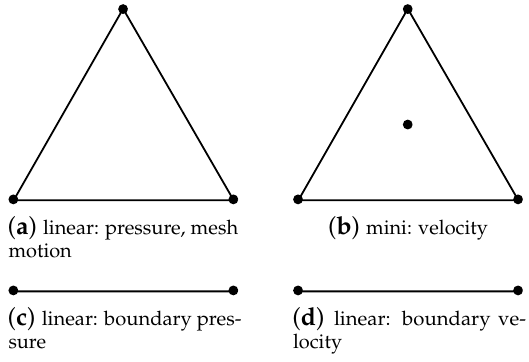
Figure 1. Interpolation nodes for the triangle finite elements and boundary finite elements used in the current work. The linear element was used to evaluate pressure at the corner nodes and mesh update, while the mini and linear boundary element were used to evaluate velocity at all element nodes. The combination of these two triangle elements generates the P 1 + P 1 finite